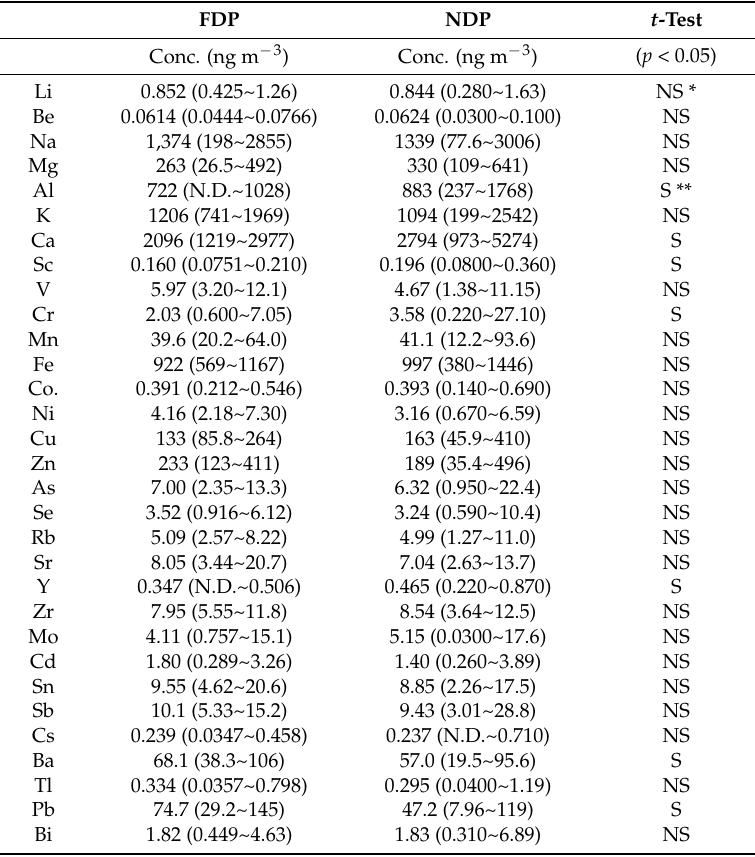
Table 1. Statistical description of concentrations of 31 selected metals (ng m − 3 ) in PM 10 during FDP and NDP. FDP